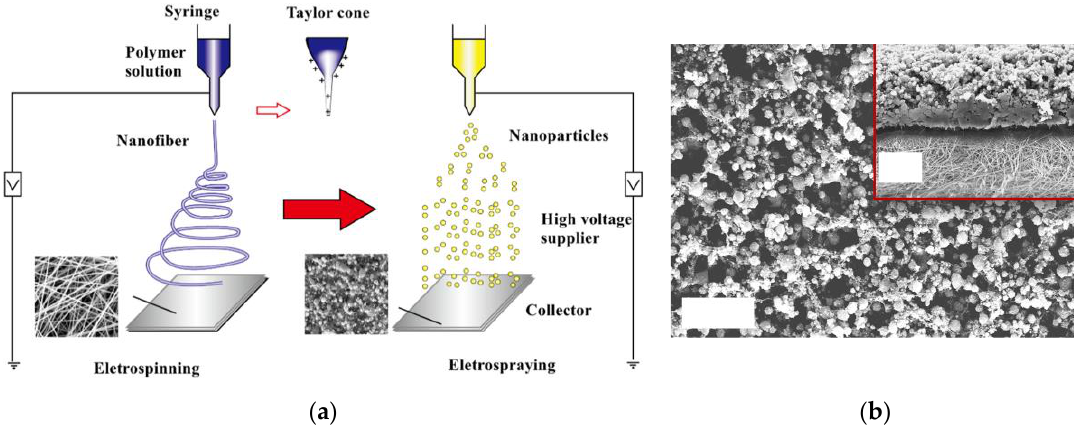
Figure 6. ( a ) Fabrication procedure of TiO 2 electrospun nanofiber by the electrospinning– Figure6. ( a )FabricationprocedureofTiO 2 electrospunnanofiberbytheelectrospinning–electrospraying electrospraying process and ( b ) SEM image of the prepared membrane [79]. process and ( b ) SEM image of the prepared membrane